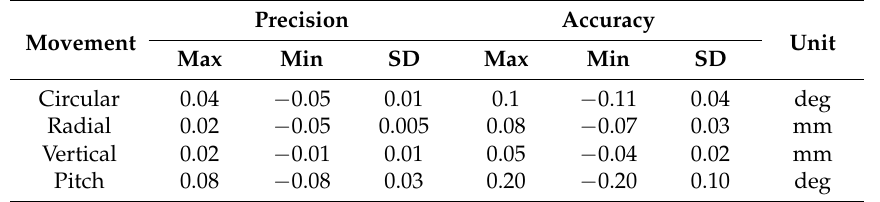
Table 1. Maximum, minimum, and standard deviation of positioning error observed among all the position